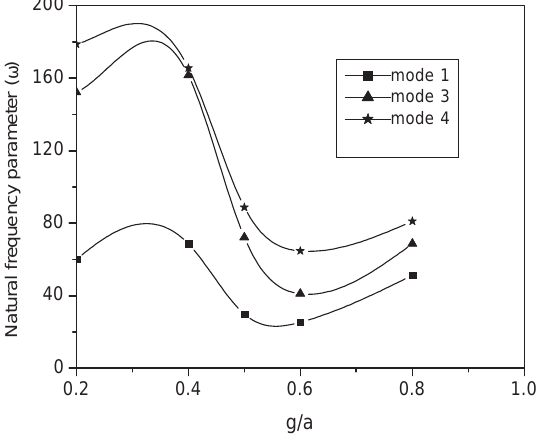
Fig. 12. Frequency parameters for a simply supported stiffened square plate having three equispaced stiffeners with square cutouts subjected to uni-axial compressive forces.